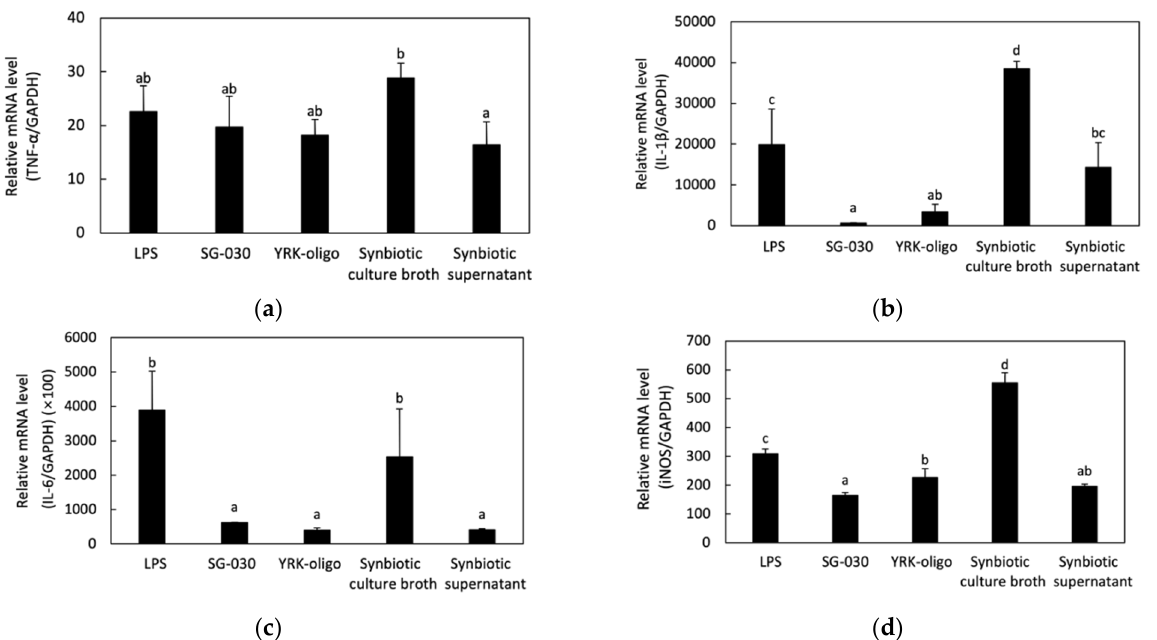
Figure 4. Effects of synbiotics on the mRNA expression of cytokine genes and iNOS gene in RAW 264.7 cells. ( a ) Relative mRNA expression level of TNF-α gene; ( b ) Relative mRNA expression level of IL-1β gene; ( c ) Relative mRNA expression level of IL-6 gene; ( d ) Relative mRNA expression level of iNOS gene. RAW 264.7 cells were treated with L. lactis SG-030 alone, oligosaccharides alone, symbiotic culture broth, and symbiotic supernatant. (n ≥ 3). LPS, lipopolysaccharides; SG-030, L. lactis SG-030; YRK-oligo, 0.5 μg/mL of oligosaccharides from W. cibaria YRK005. Different letters show significant differences among groups at p < 0.05 (n ≥ 3).